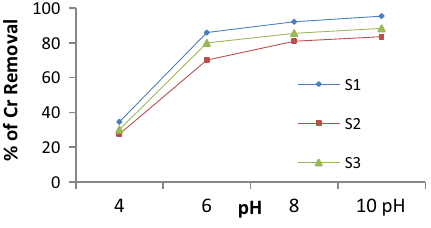
Fig. 6 Effect of pH on % removal of Cr by tea waste adsorbent